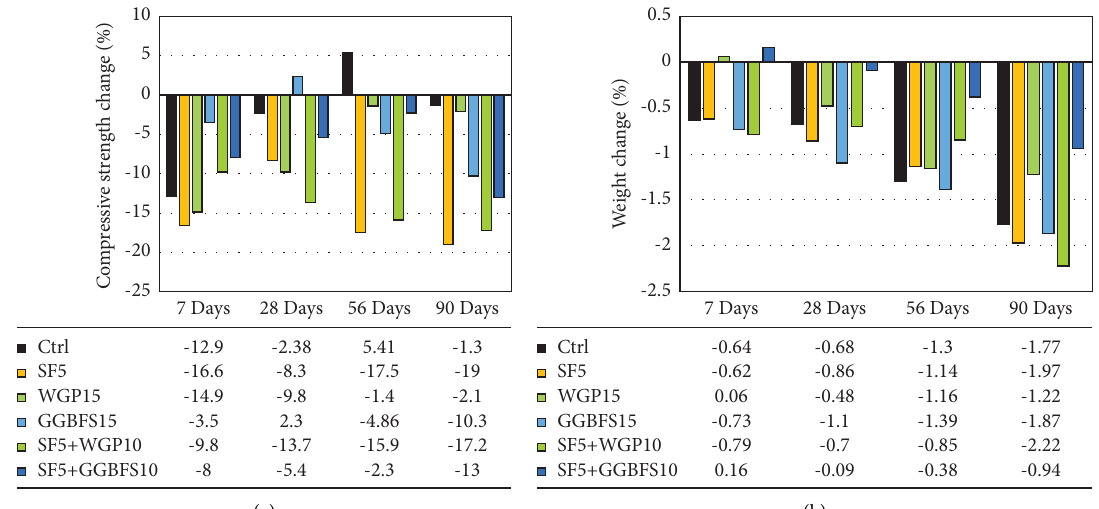
Figure 9: (a) Compressive strength changes in concrete after exposure to sulfuric acid. (b) Changes in concrete weight after exposure to sulfuric